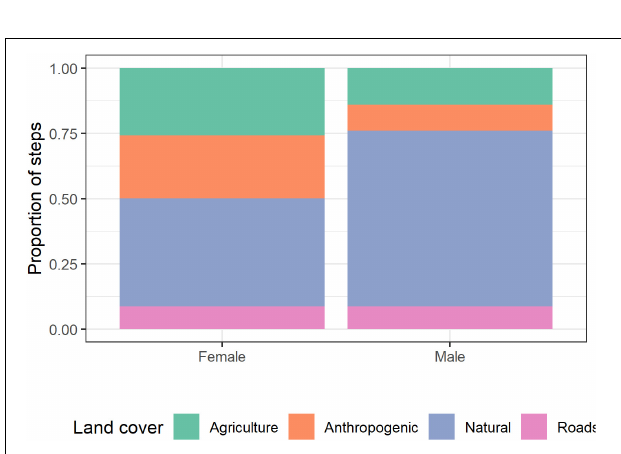
FIGURE 5 | The proportion of GPS locations in each land cover type for male and female striped hyenas in the Central District of